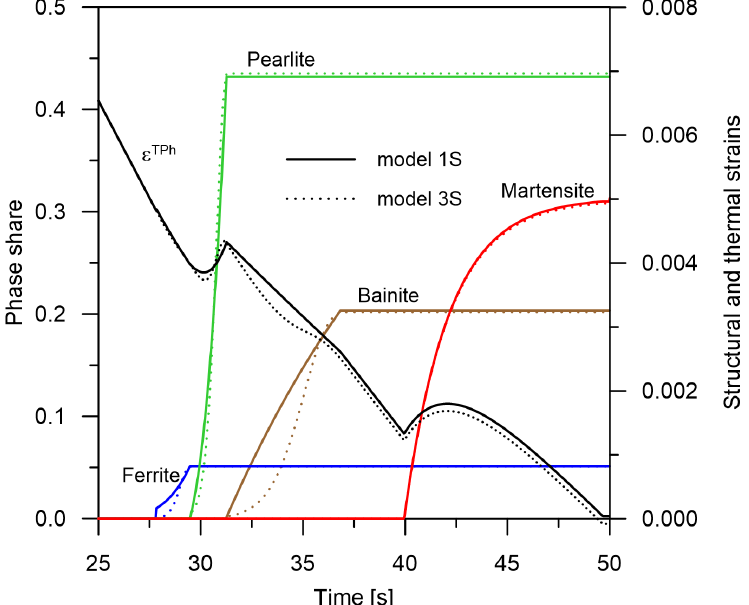
Figure 4. A comparison of the kinetics of transformations and the strains ε T + ε ph for 1S and 3S models. The CCT diagrams used in the model were made in such a way that the time of the onset of austenite decomposition is 0 when the cooling curve reaches the A c 3